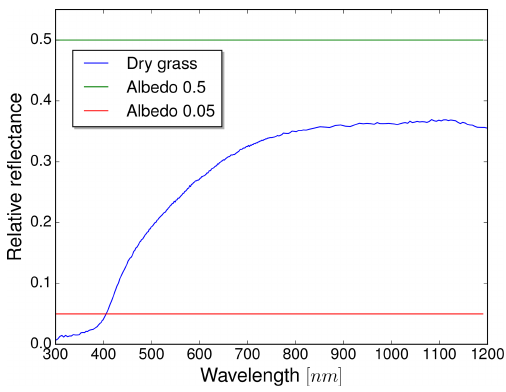
Figure 8. Reflectance of dry, brown vegetation; dataset AV87-2 (Clark et al.,